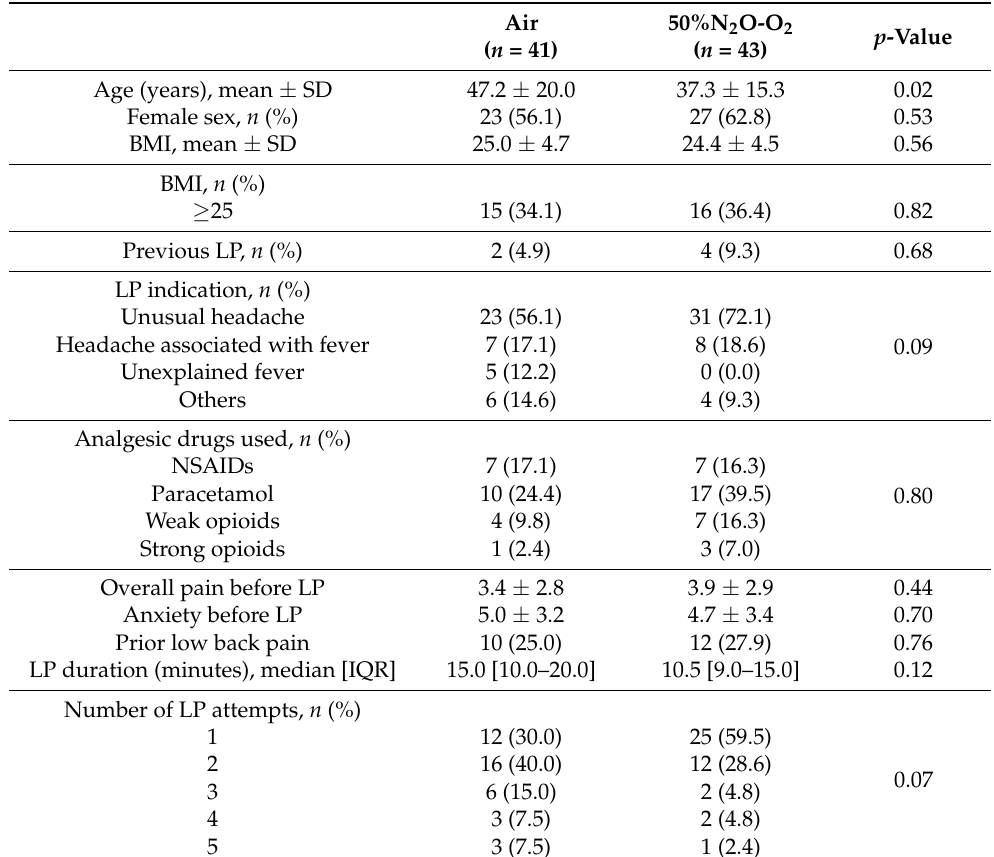
Table 1. Demographic and baseline characteristics of the 84 patients with completed data, by randomization group. Four patients’ files were completely empty.